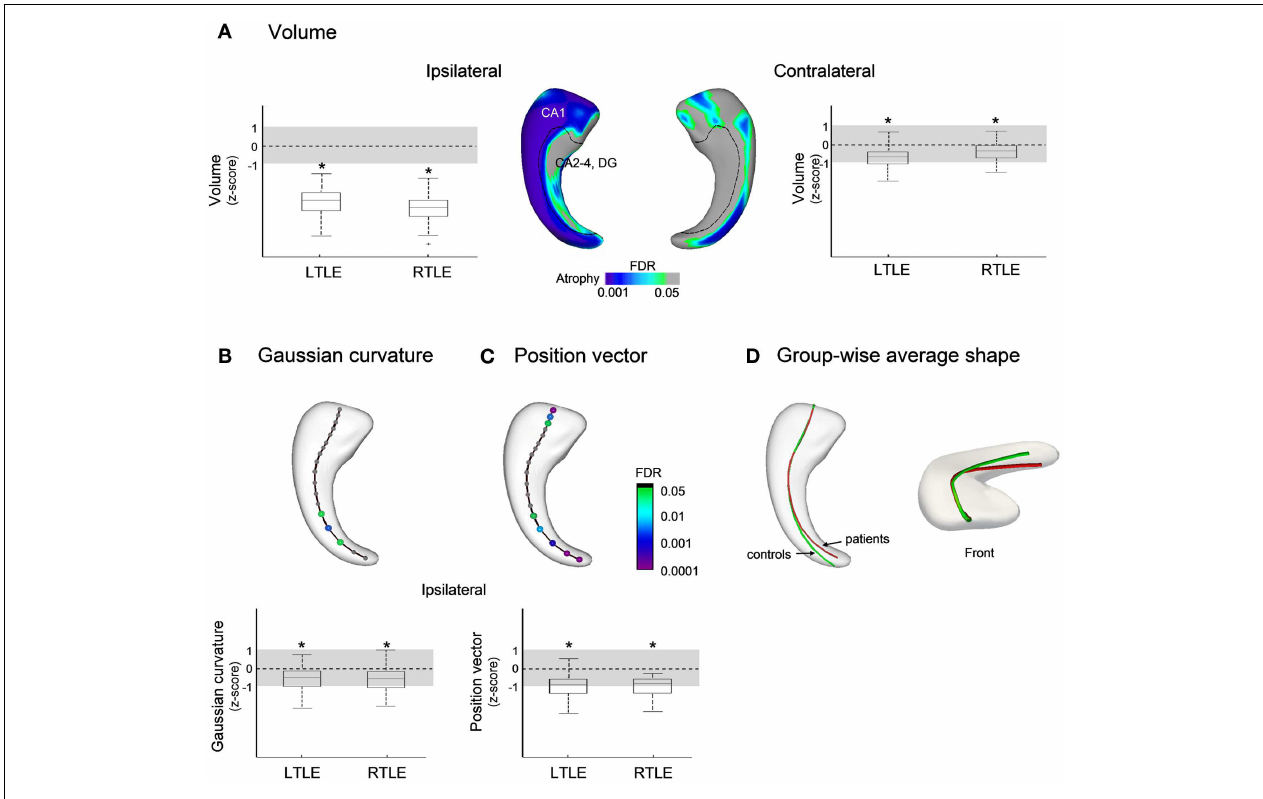
Box-and-whisker plots present group differences between each patient group standardized relative to healthy controls; the solid line indicates the mean and the dotted lines represent ± 1 SD from the mean. Color-scales refer to FDR-corrected p -values, and L (left) and R (right) to seizure focus